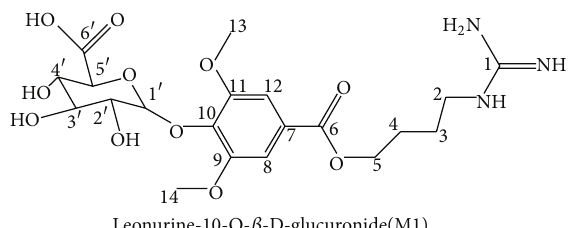
Figure 6: The authentic structure of metabolite